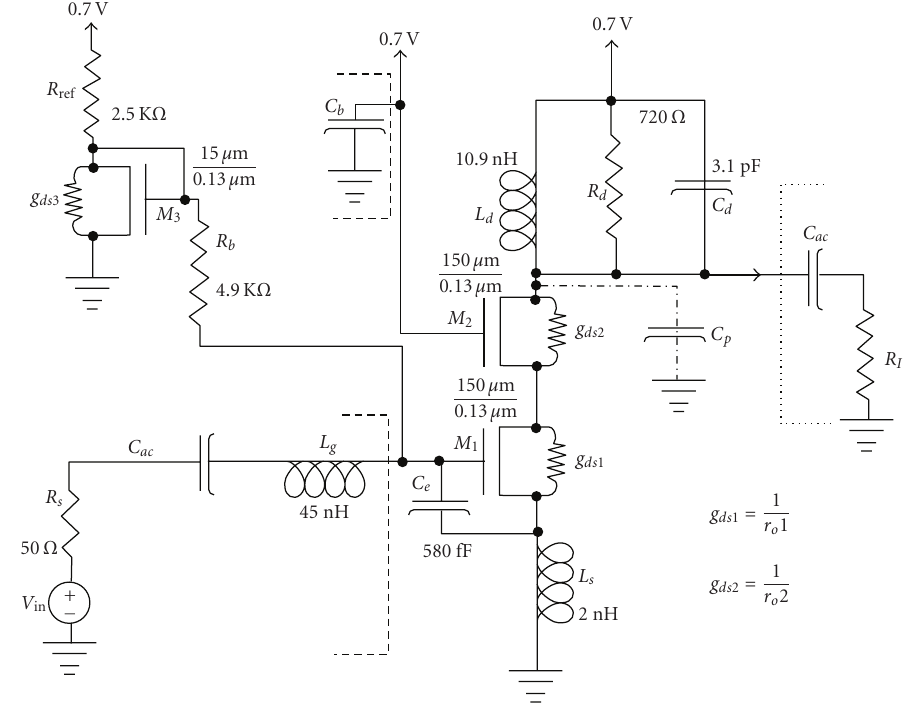
Figure 1: Proposed narrow-band circuit topology for 866MHz RFID LNA.